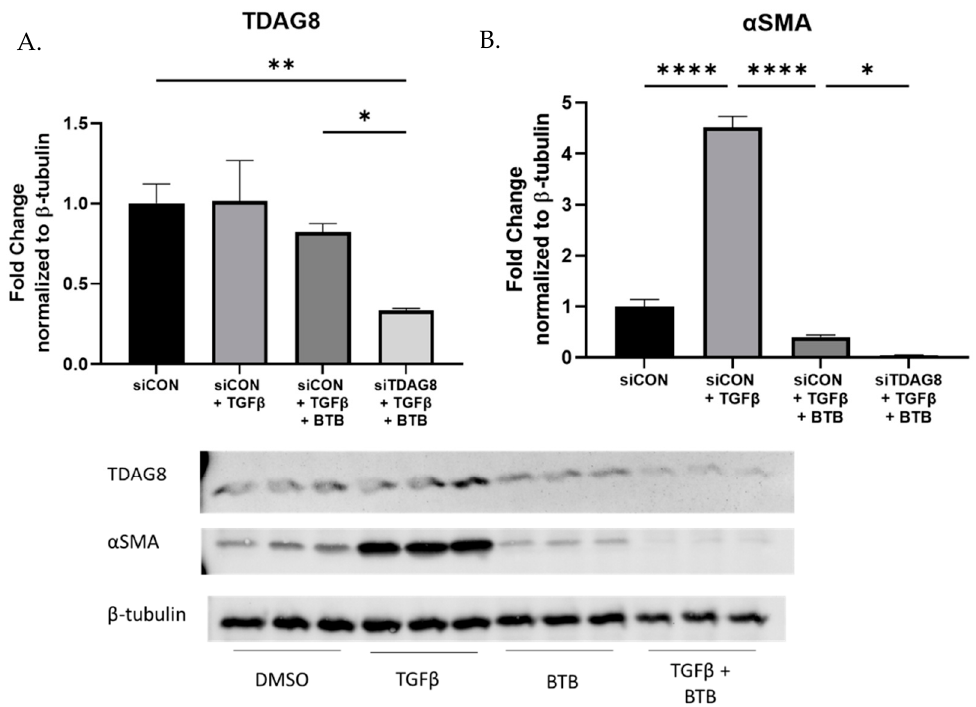
Figure 6. BTB does not require TDAG8 to inhibit myofibroblast differentiation. Fibroblasts were transfected for 18 h, upon which time media was changed. After 54 h, fibroblasts were challenged with 1 ng/mL TGF β and/or 50 µM BTB. Fibroblasts were incubated for another 48 h prior to protein harvest. TDAG8 knockdown was confirmed ( A ) and lysates were examined for expression of α SMA ( B ). Data were analyzed by ANOVA. n = 3 technical replicates/group. * p < 0.05, ** p < 0.01, **** p < 0.0001.